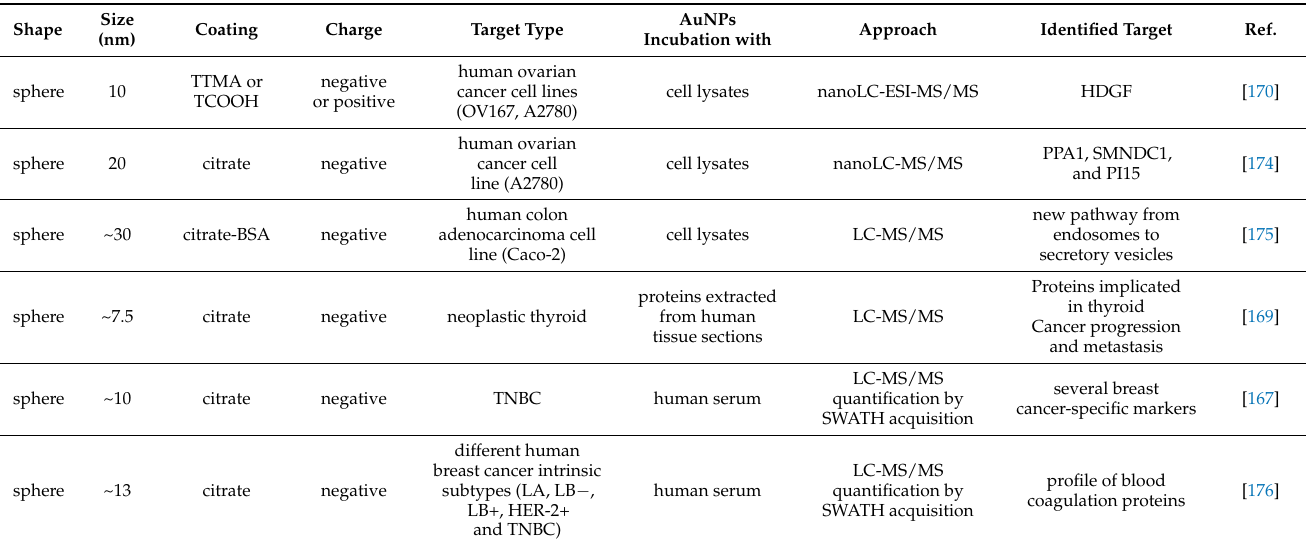
Table 2. A summary of literature findings using proteomic approaches based of